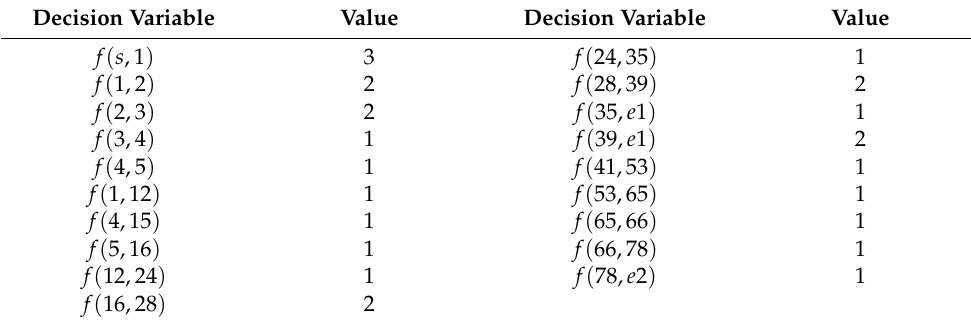
Table 6. The solution obtained by solving NOP.